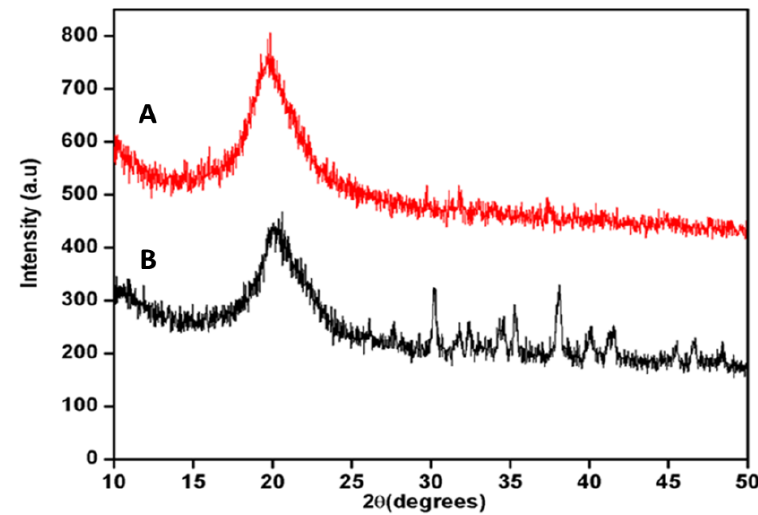
Figure 10. XRD spectra of chitosan beads and Man/Cel5B immobilized beads. ( A ) Chitosan beads. ( B ) Man/Cel5B immobilized chitosan beads.